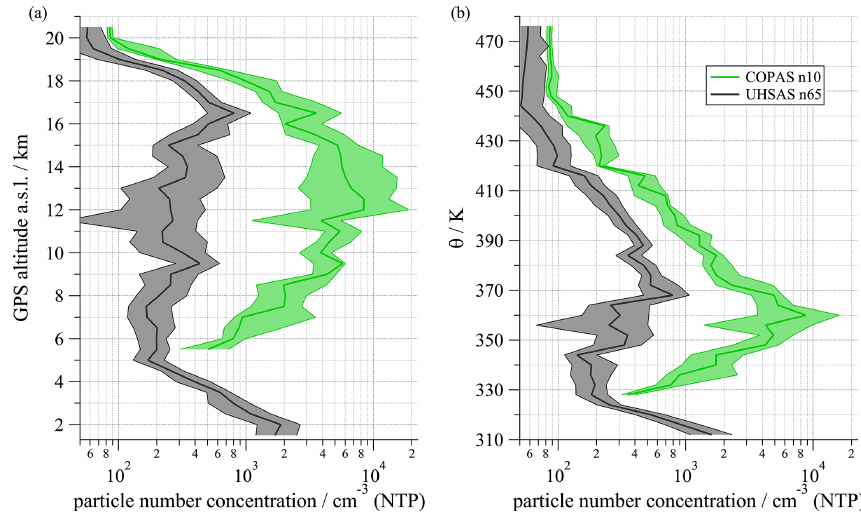
Figure 3. Vertical profile of the median submicron aerosol particle number concentrations as measured by COPAS and the UHSAS-A (n10, n65: particles with diameters larger than 10 and 65nm, respectively) as a function of (a) GPS altitude and (b) potential temperature θ